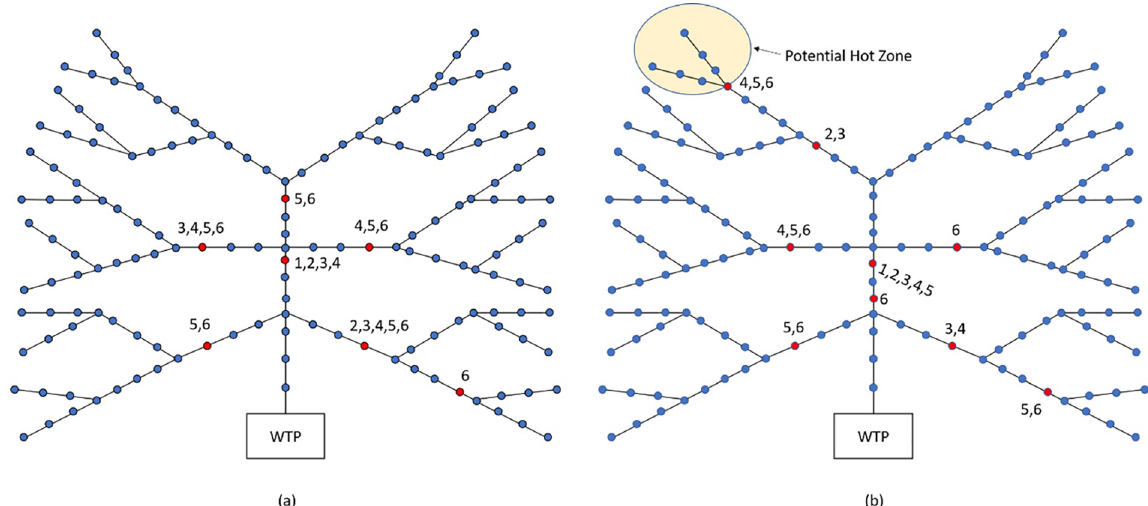
Fig 8. Optimal locations of 1 to 6 sensors. The number # on the red nodes indicates that the manhole was chosen when locating # sensors. Panel b shows the hotspot.